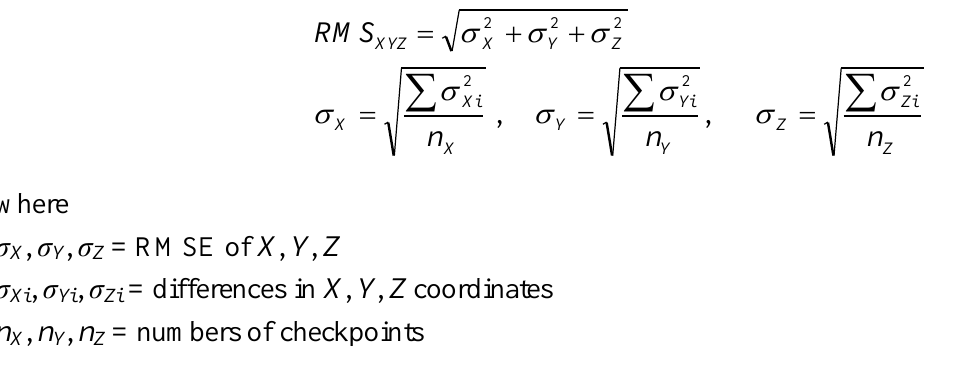
Figure 4. Influence of interior parameter